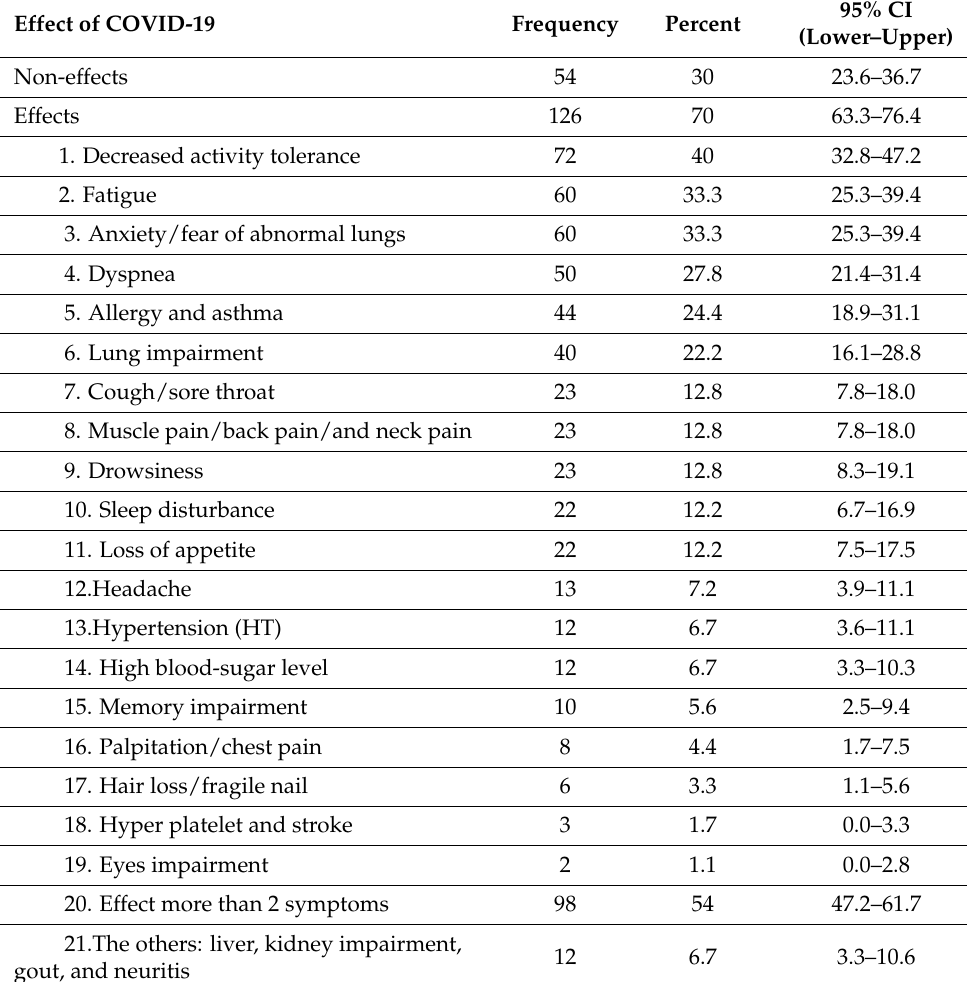
Table 4. Post-COVID-19 effects (n =